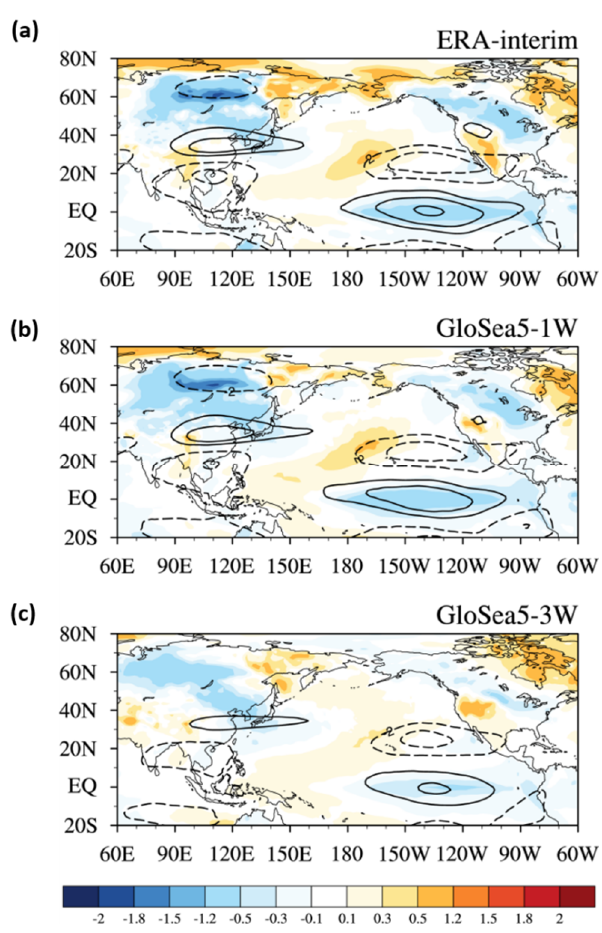
Figure 5. Surface temperature (shaded) and 200 hPa zonal wind (contours) regressed on the East Asia winter monsoon (EAWM) from ( a ) ERA–Interim, ( b ) GloSea5 with a lead time of 1 week, and ( c ) GloSea5 with a lead time of 3 weeks.